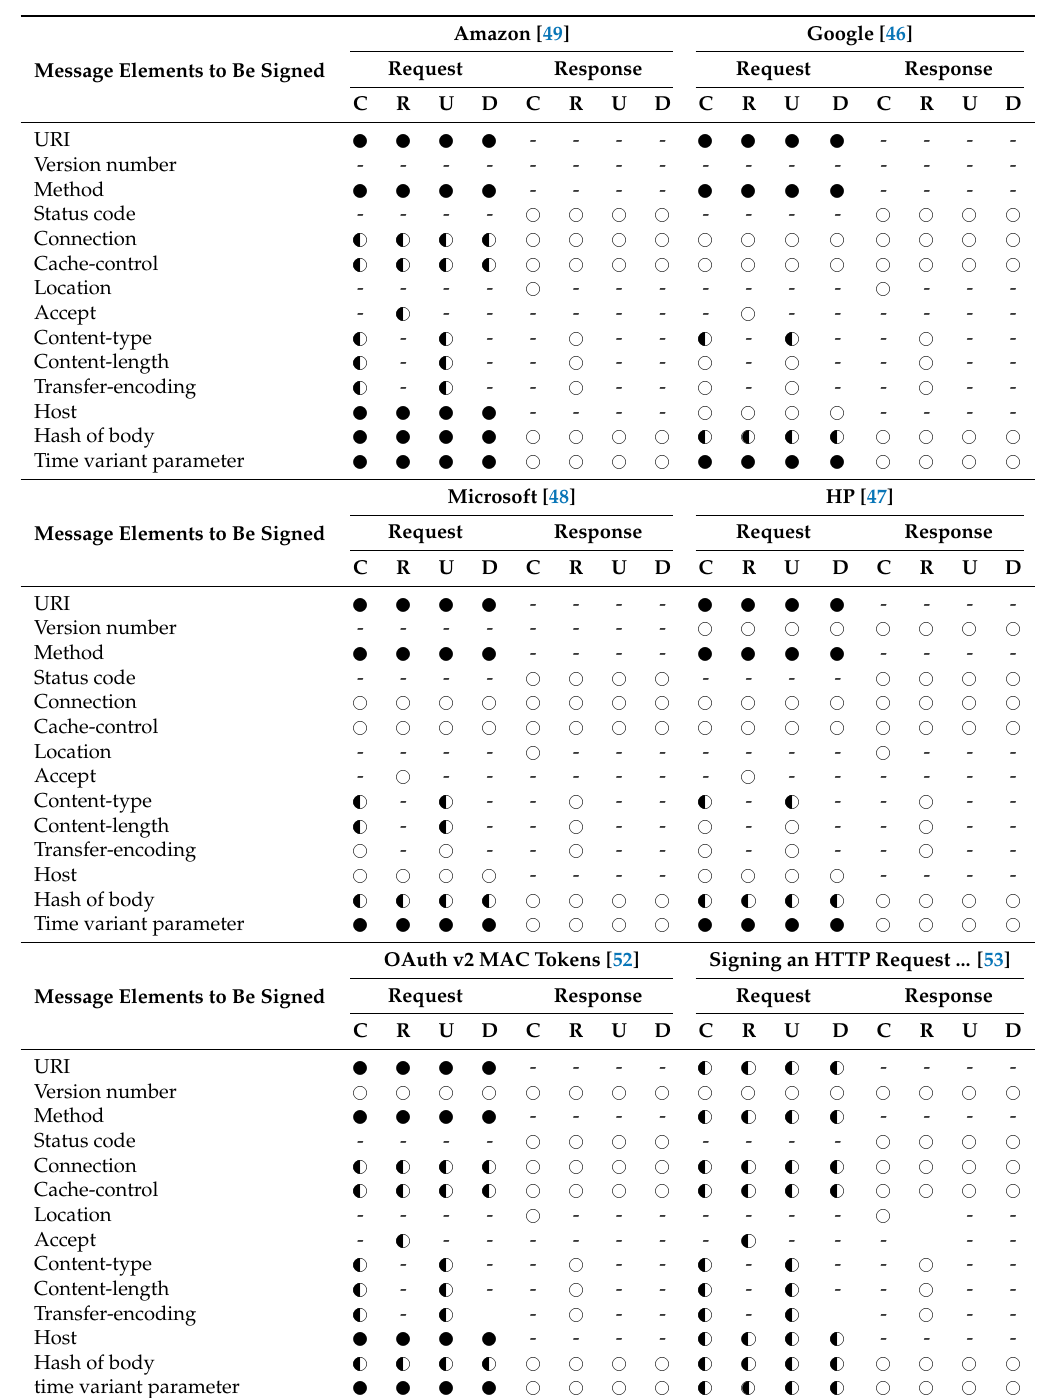
Table 2. Analysis of related work in HTTP message authenticity and